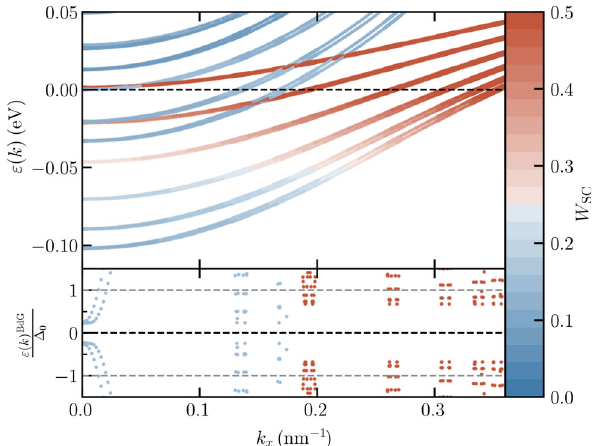
FIG. 6. Top: Band structure in the normal state at V − 0 . 15 V. Color indicates the weight of the state in the super- 0 for FIG. 5. Eigenstates of the Hamiltonian Eq. (4) at k x ¼ − 0 . 15 V, V 0 V, and V 0 . 2 V. Panels (a) – (c) show V conductor. Hybridization between states is seen by the changing g ¼ g ¼ g ¼ color of the subbands. Bottom: Band structure of the system in the electrostatic potential for reference purposes, with horizontal the superconducting state. The induced gap in each subband lines denoting the bottom of each band below the Fermi energy. depends on the hybridization to the superconductor. It can The color scale indicates the weight in the superconductor, and in clearly be seen that bands with stronger hybridization (red) are the semiconducting part, the intensity indicates the square characterized by a larger induced gap. Here we used the same modulus of the eigenstate. Panels (d) – (f) show the eigenfunctions parameters as in Figs. 5(a) and explicitly with the same color coding.